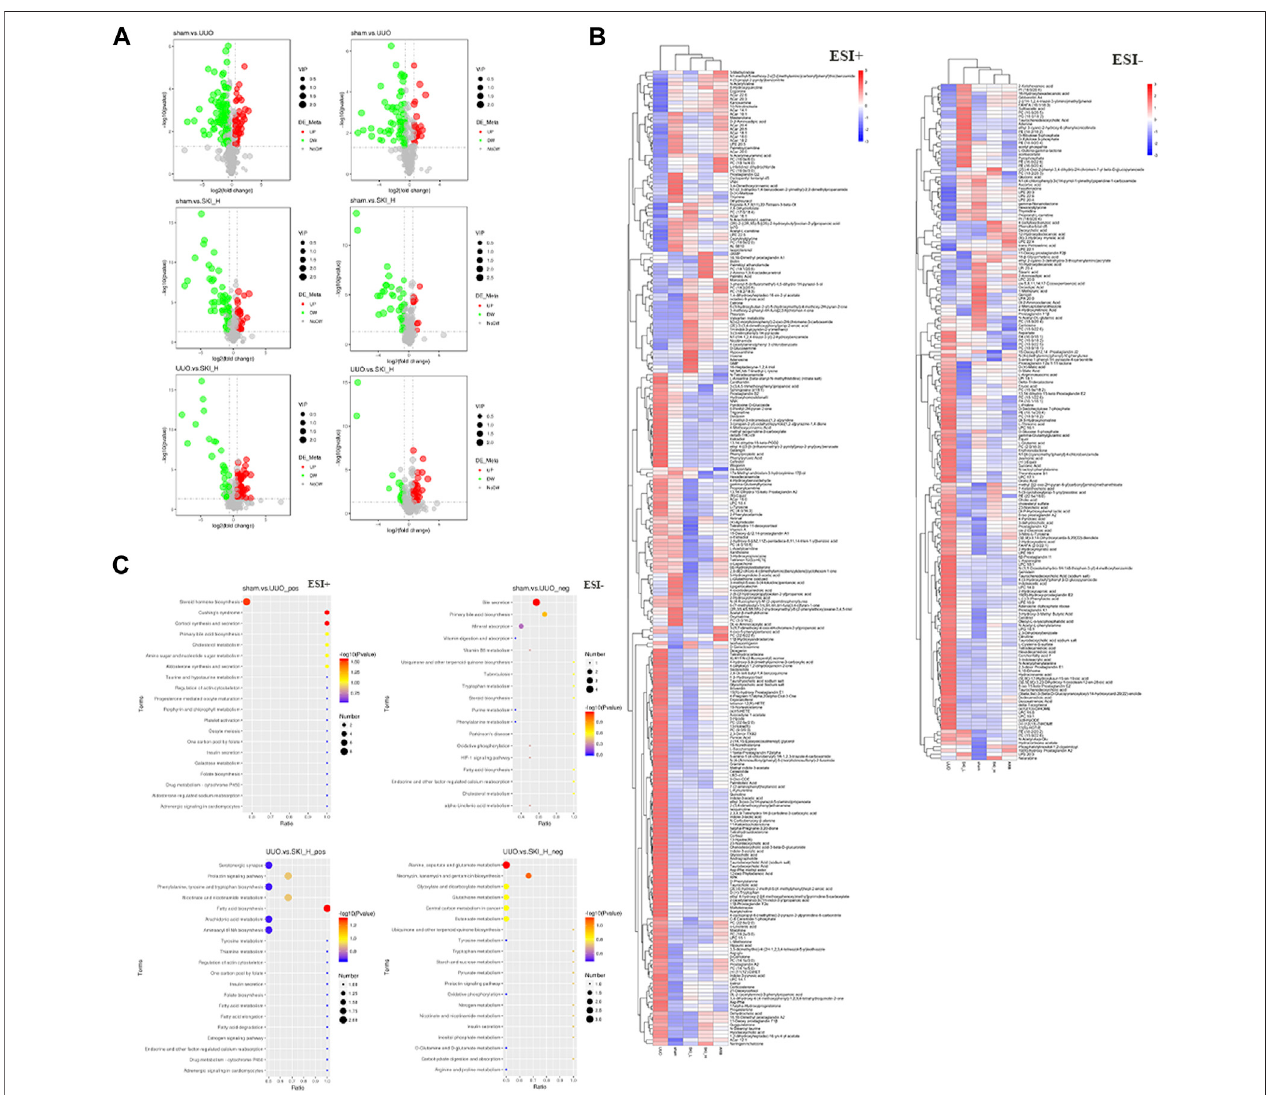
FIGURE 14 | Metabolomic analyses of mice samples from the Sham, UUO and SKI groups. (A) Differential metabolite volcano map. Each dot in the volcano map representsametabolite;thesigni fi cantlyupregulatedmetaboliteisrepresentedbyreddots,thesigni fi cantlydownregulatedmetaboliteisrepresentedbygreendots,and the size of the dot represents VIP value. (B) Differential metabolite cluster heat map. (C) KEGG enrichment bubble diagram. Color saturation indicates the metabolite expression value, blue represents the lowest expression, and red represents the highest expression.